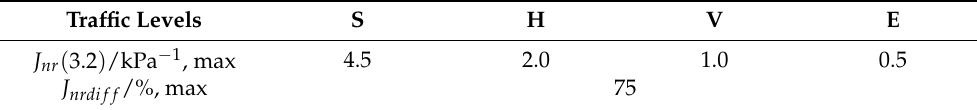
Table 2. J nr ( 3.2 ) and J nrdif f for different traffic levels. Table 2. 𝐽 (cid:3041)(cid:3045) (3.2) and 𝐽 (cid:3041)(cid:3045)(cid:3031)(cid:3036)(cid:3033)(cid:3033) for di ff erent tra ffi c levels.